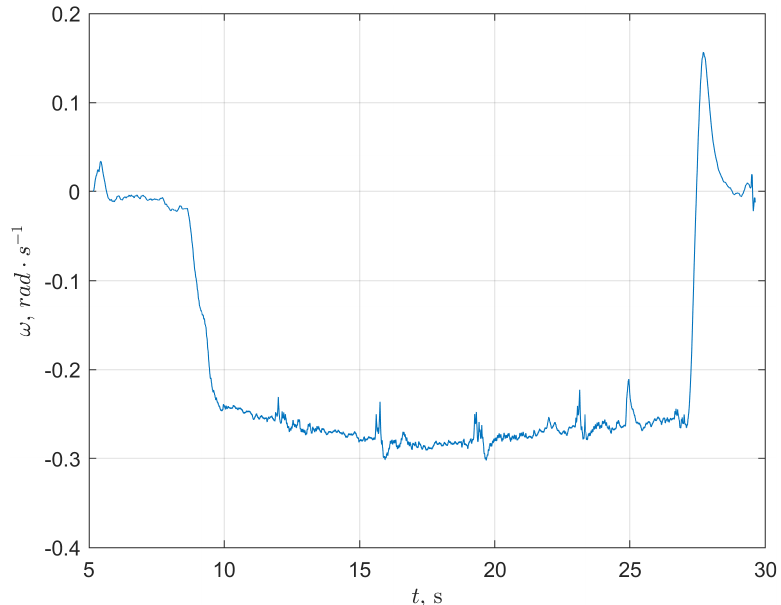
Figure 30. Changes in angular rate over time for the highest value of the cost function equal to 1.3732—track 2.